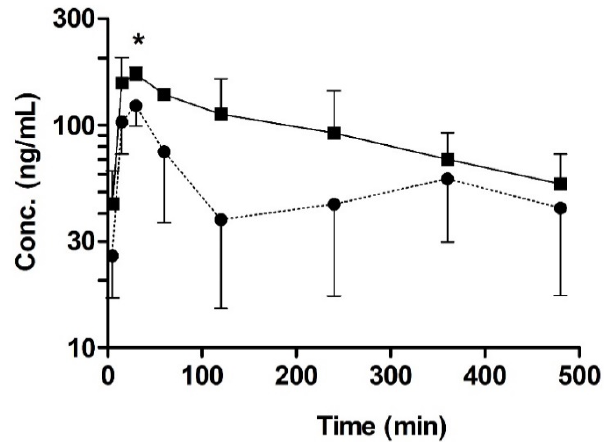
Figure 6. Temporal profiles of orally administered sulfasalazine (2 mg/kg) with or without the pre-administration of quercetin (10 mg/kg). Key: Control ( ● ; without quercetin), quercetin pre-administration ( ■ ). Asterisks indicate statistical differences from the control (i.e., without quercetin) according to a two-tailed/unpaired Student’s t-test (* P < 0.05, power > 0.8). Data are expressed as the mean ± SD of quadruplicate runs. Table 1. Pharmacokinetic parameters of sulfasalazine after its oral administration (2 mg/kg dose) with and without pretreatment with quercetin (10 mg/kg) in rats. Data are expressed as the mean ± SD ( n = 4 per group).